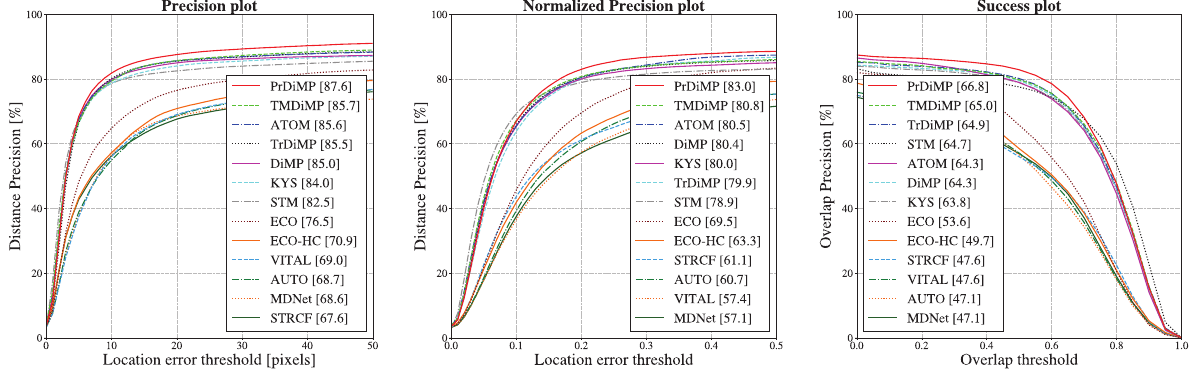
Figure 10. Precision, normalized precision, and success plots of OPE on